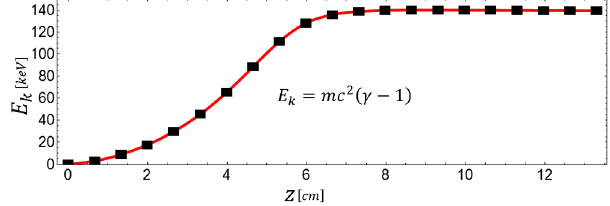
FIG. 8. CST simulation results for variations of the beam energy along the CLIC thermionic gun.